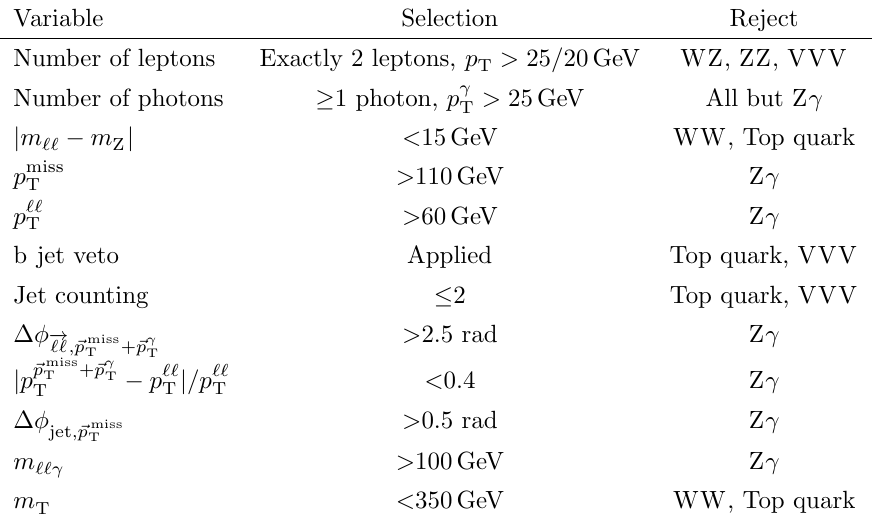
fraction is twice that of either same (cid:13)avor lepton pair (cid:12)nal state, is used to estimate